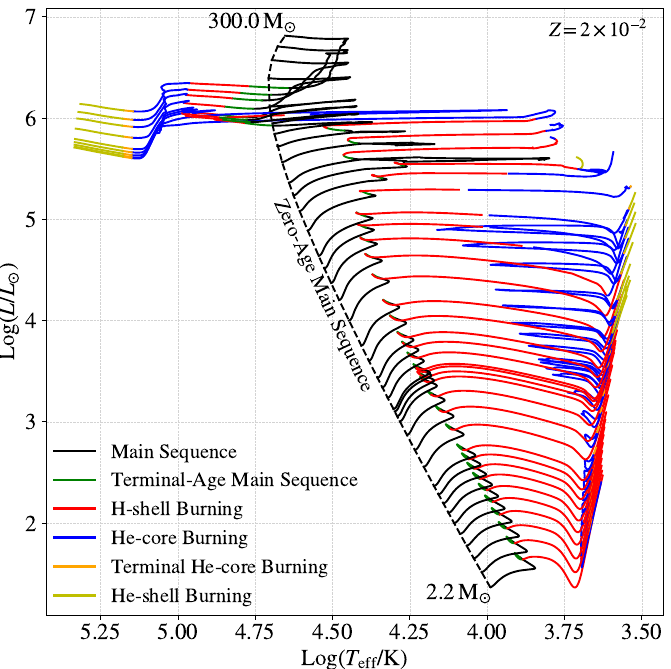
Figure 1. Hertzsprung-Russell diagram (luminosity versus effective temperature) that shows the ZAMS (dashed black line) of stars with masses in the range 2.2M (cid:12) –300M (cid:12) , at metallicity Z = 2 × 10 − 2 . The plot also shows the stars’ main evolutionary stages (solid lines) until carbon ignition, and it has been obtained through the SEVN population-synthesis code [97] coupled with the look-up tables for single-star evolution from the PARSEC code